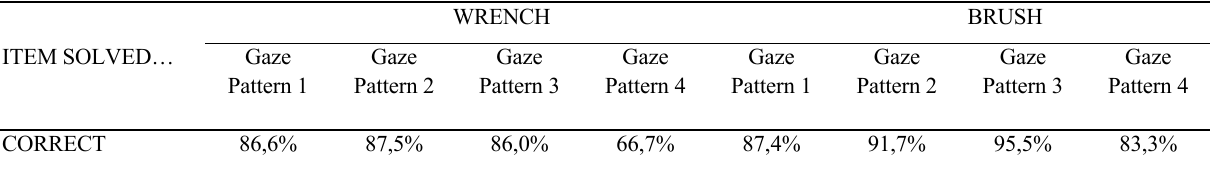
Table 1: The percentage of correctly and incorrectly solved items for wrench and brush in the different gaze patterns. WRENCH BRUSH ITEM